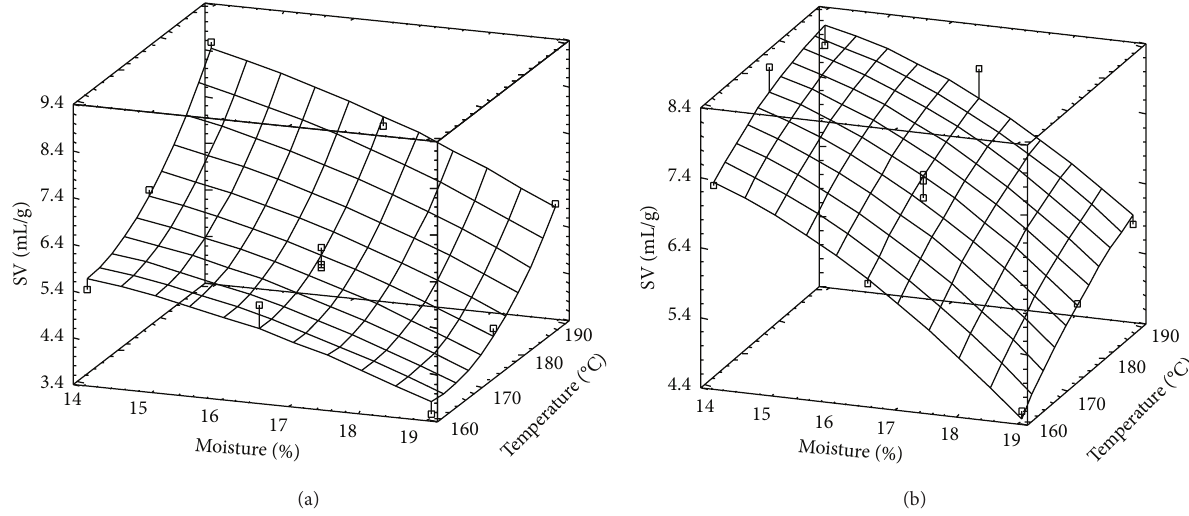
Figure 3: Surface response for specific volume (SV) corresponding to Fortuna rice variety (a) and Paso 144 rice variety